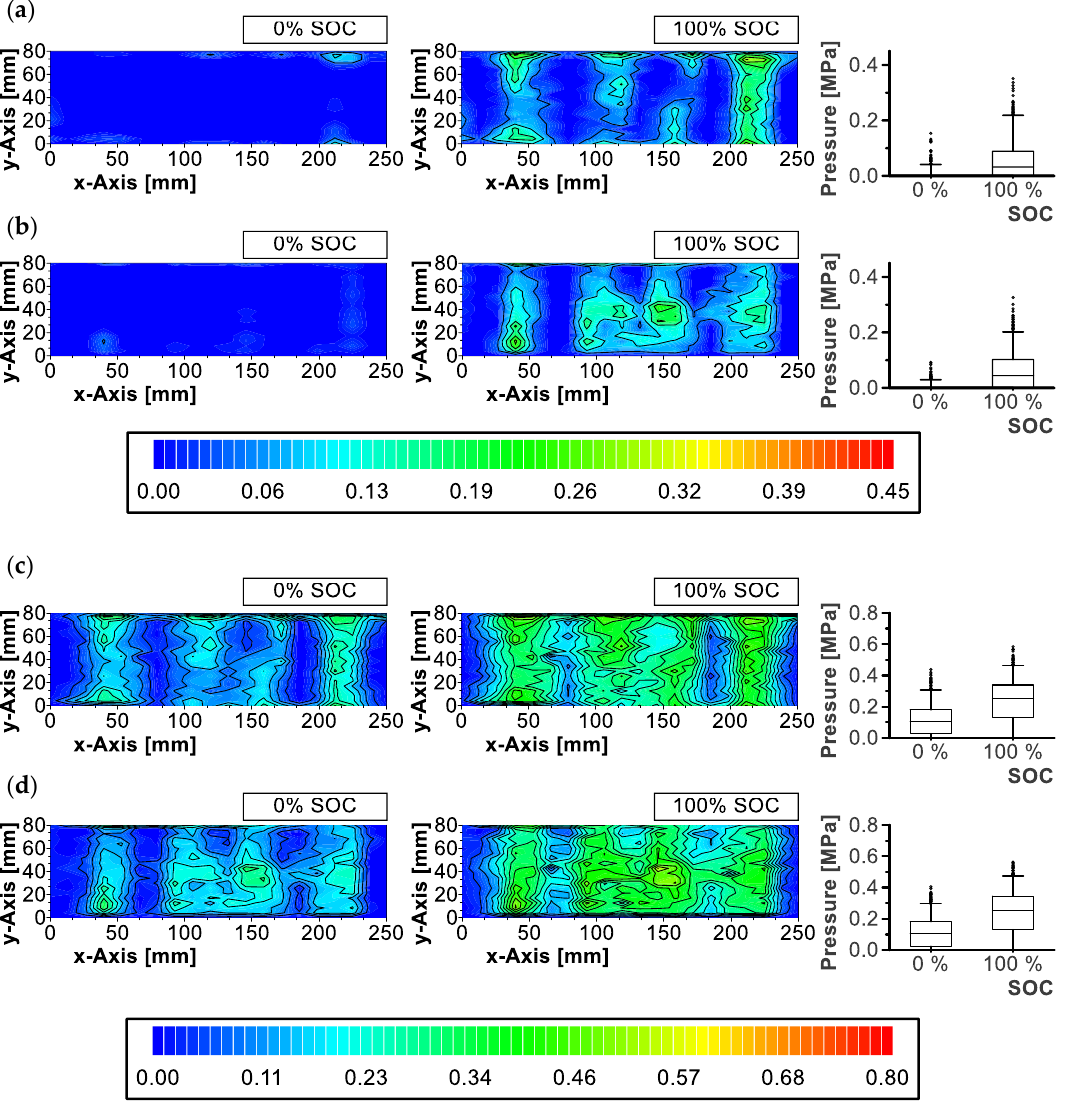
Figure 6. Pressure distribution in MPa of two fresh reference cells F1 and F2 at 0% and 100% SOC with ( a ) F1 and F pre = 300 N, ( b ) F2 and F pre = 300 N, ( c ) F1 and F pre = 4000 N and ( d ) F2 and F pre = 4000